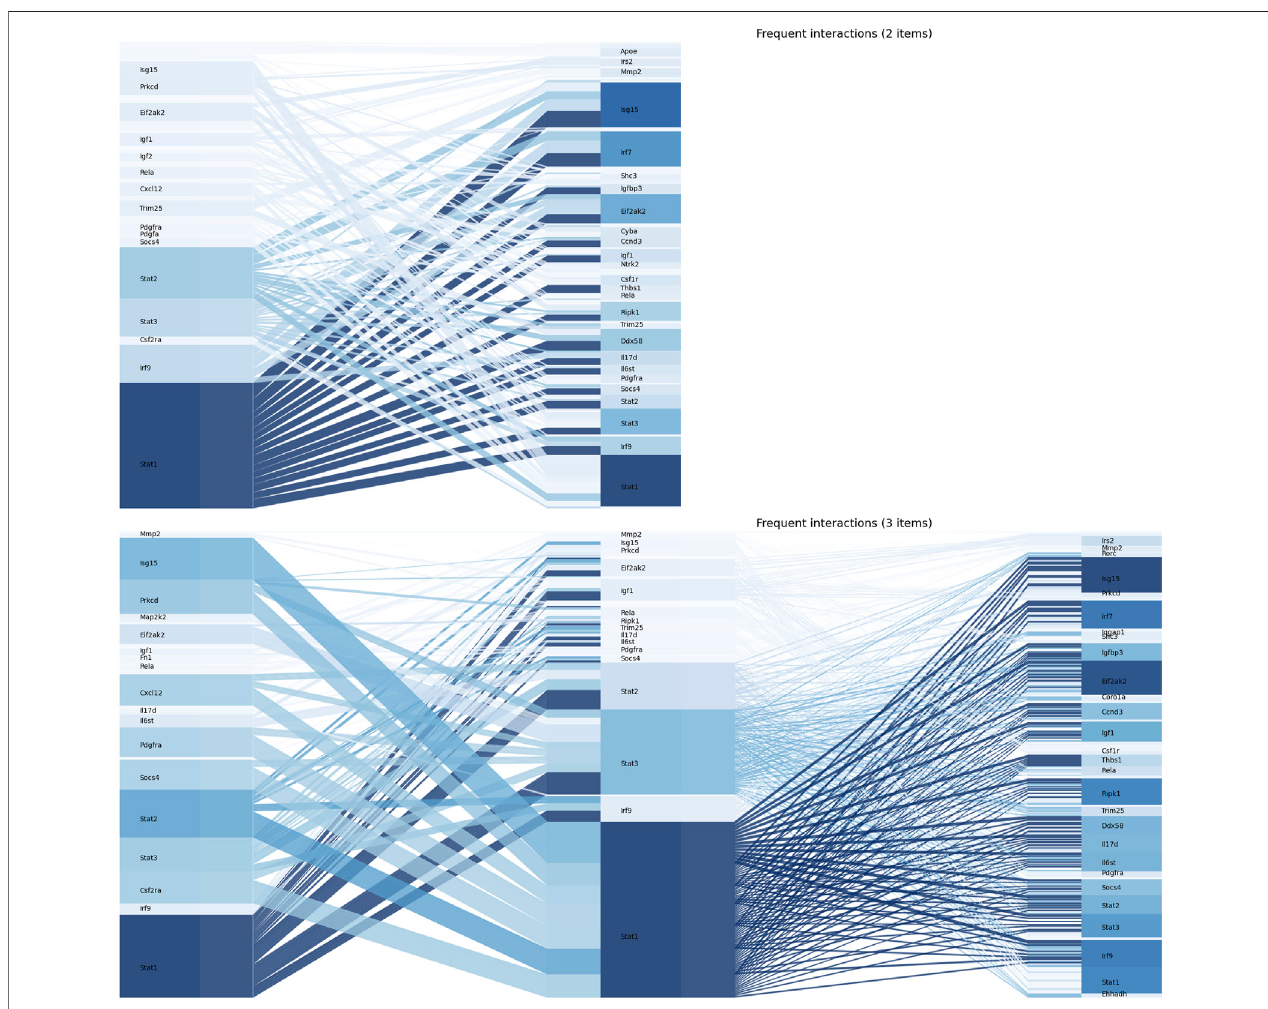
FIGURE 4 | The fi gure illustrated d values and their interactions in frequent gene sets. The upper panel showed the expression patterns of frequent gene sets with two items, while the lower panel showed the expression patterns of frequent gene sets with 3